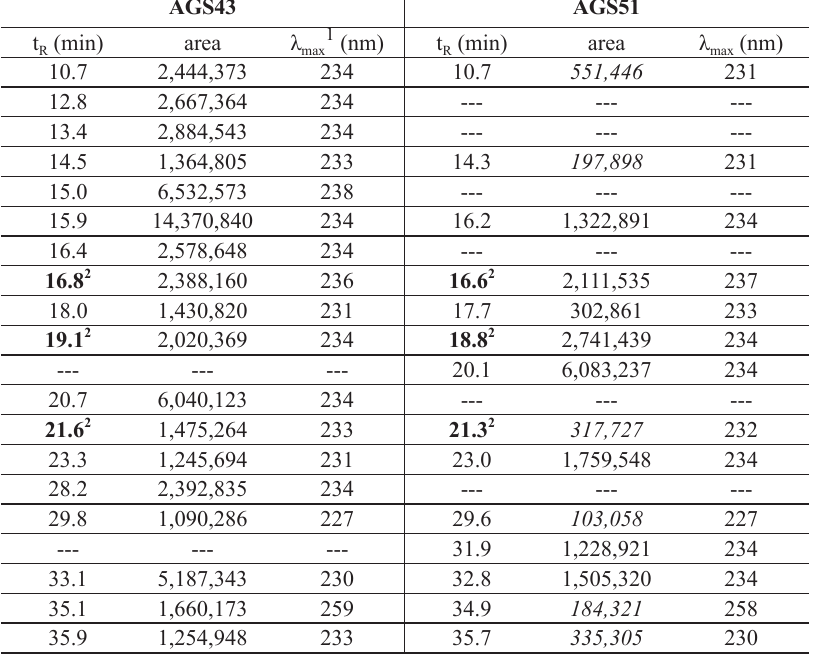
Data from HPLC-DAD analyses of specimens AGS43 and AGS51. Retention time, area and λ of selected peaks (t > 10 min; area >10 6 in at least one specimen of the group) are presented. R